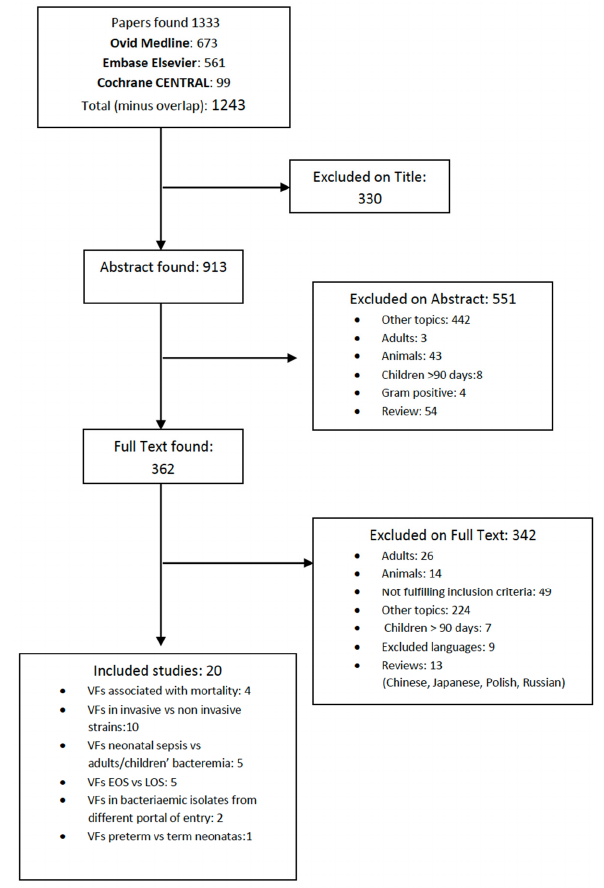
Figure 1. Identification, screening and eligible publications.